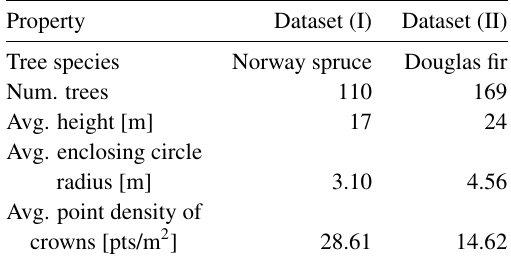
Table 1. Properties of reference